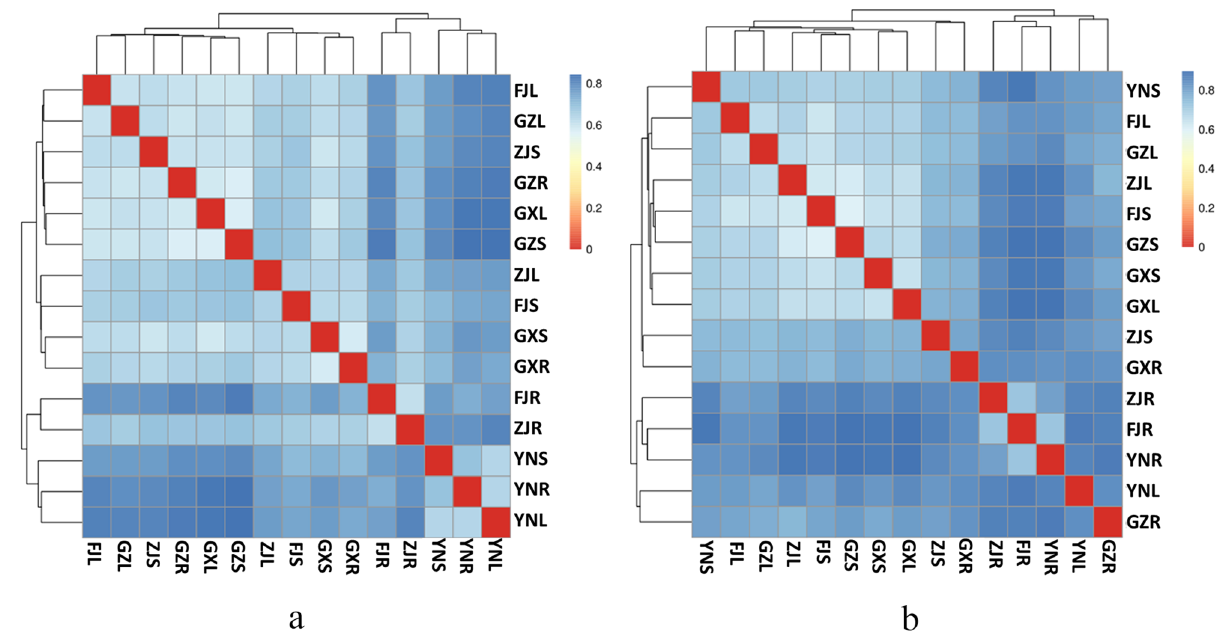
Fig 1. The unweighted heatmap based on 16S rRNA (a) and nif H (b) communities.